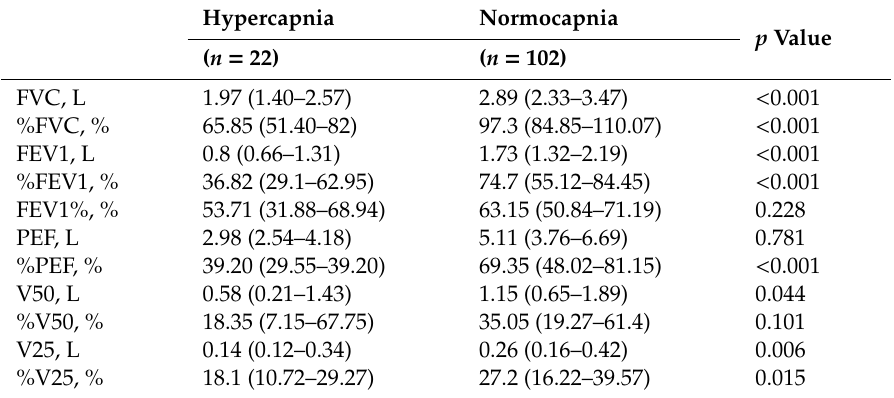
Table 2. Pulmonary function test values of enrolled subjects with